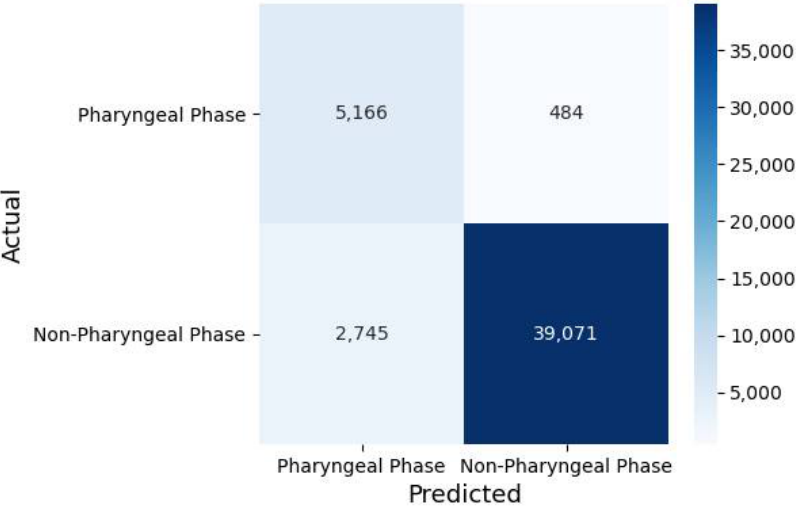
Figure 8. Confusion matrix of best performing classification model (fifth iteration of VGG16-FT5) in this study.